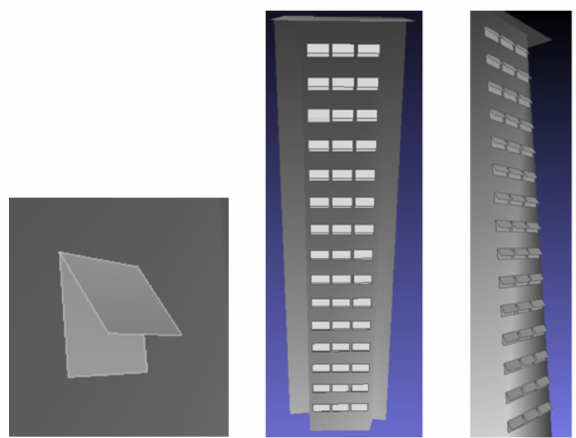
Figure 5. Final matching result after a number of LSM iterations